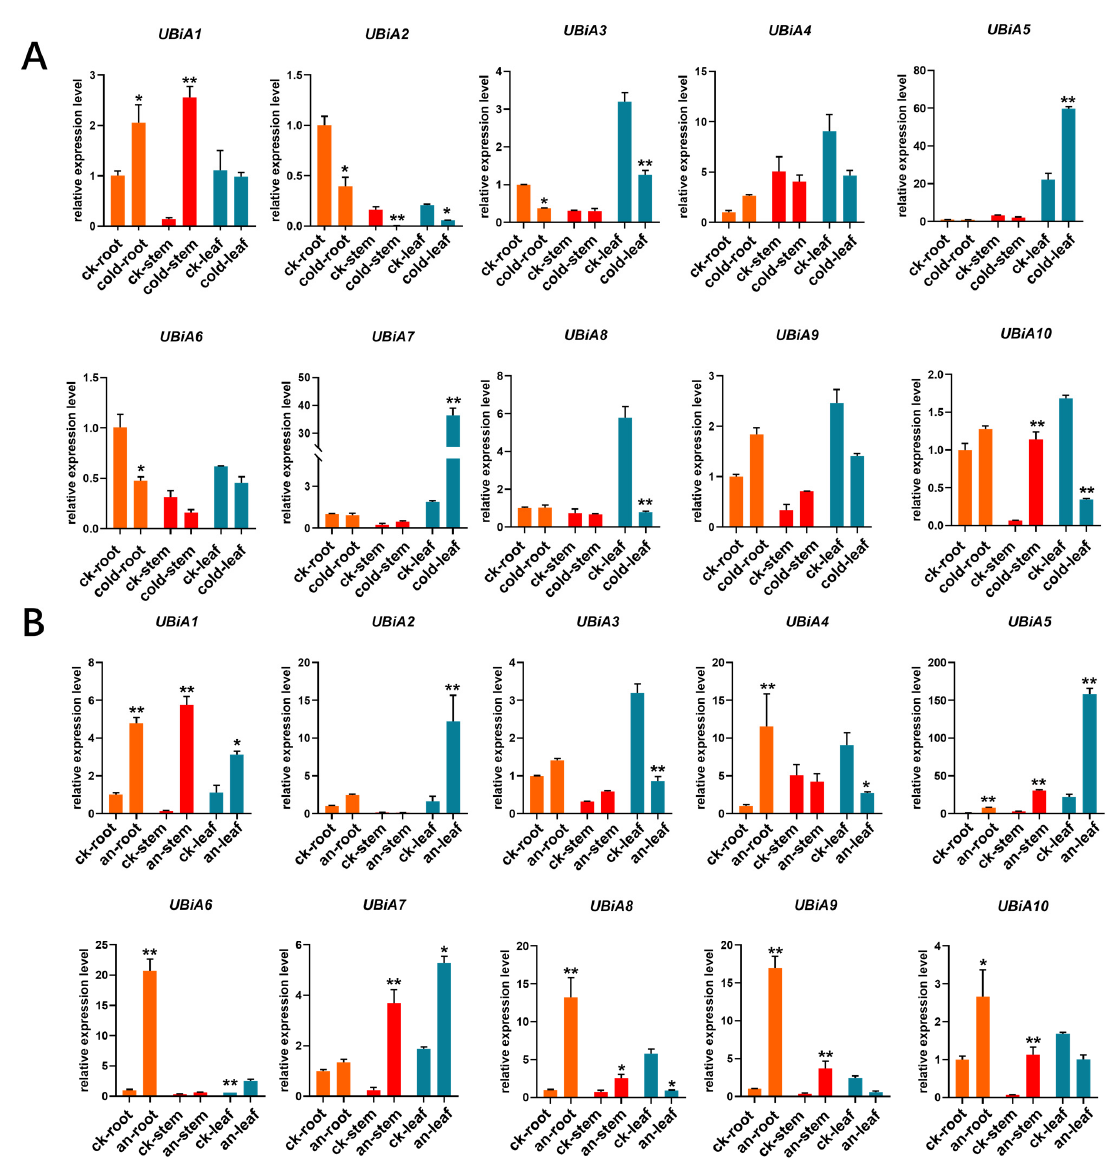
Figure 7. Expression patterns of HaUBiA genes in the roots, stems, and leaves under abiotic stress. ( A ) Under the treatment of low temperatures. ( B ) Under the treatment of anaerobic stress. HaTubulin was used as an internal control. Values were presented as means ± SD ( n = 3). (* p < 0.05, ** p < 0.01, Student’s t -test).